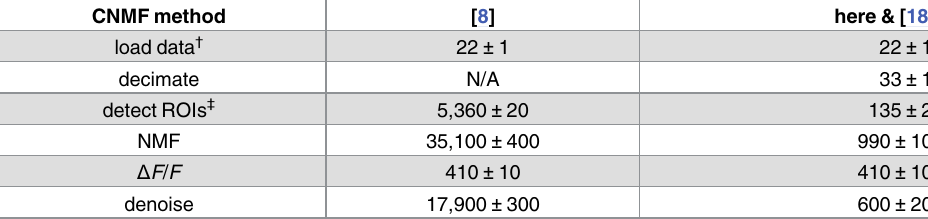
Average computing time ( ± SEM) in ms over ten runs for individualsteps of the processing pipeline on a standard laptop. The 96 × 96 patch contained N = 46 neurons recorded for T = 3000 frames. † Loading the whole data as single binary file; loading a frame at a time was an order of magnitude slower. ‡ Using greedy initialization; group lasso initialization[8] was an order of magnitude